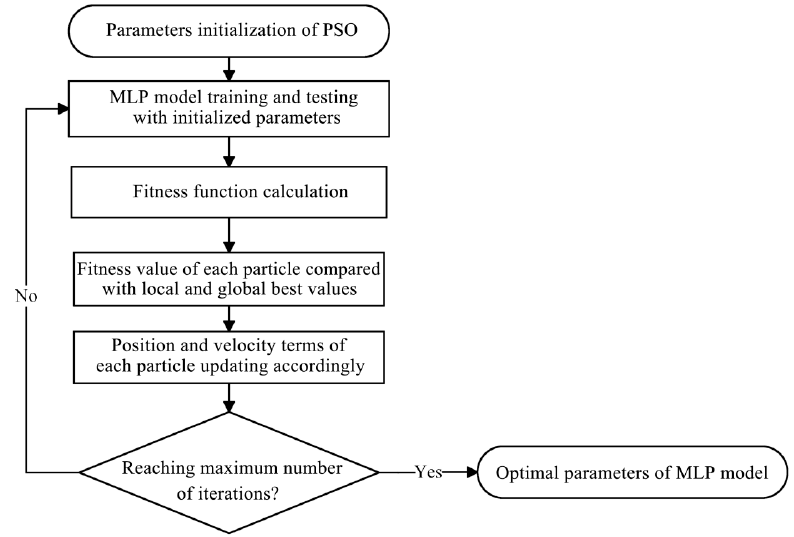
Figure 5. Flow chart of the PSO ‐ MLP model.